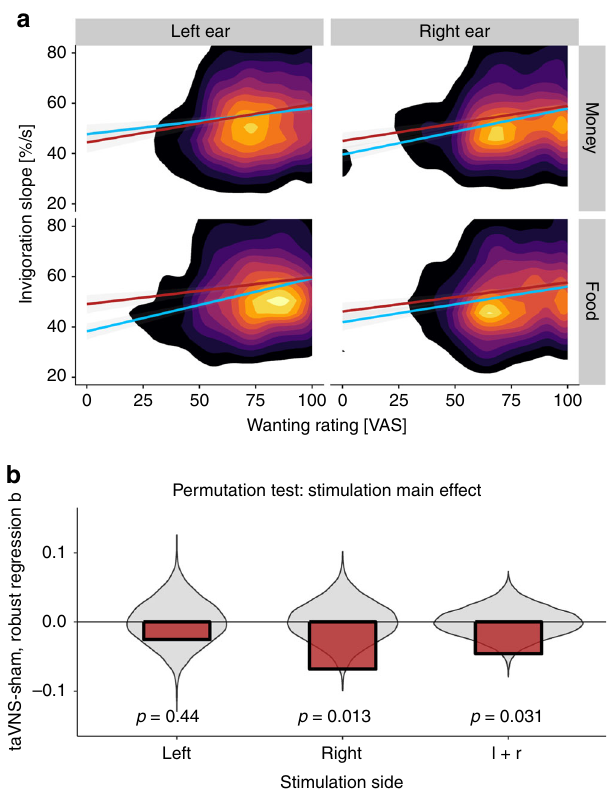
Fig. 5 Vagus nerve stimulation boosts the drive to work for less wanted rewards. a Overall, participants are slower to invigorate behavior if they want the reward at stake less as depicted in the 2d-density polygon (brighter colors indicate higher density of data). In line with univariate analyses, robust regression lines show that the slope re fl ecting the association between invigoration and wanting is decreased by transcutaneous auricular vagus nerve stimulation (taVNS: red line; sham is depicted as blue line). Again, no change was observed for monetary rewards after taVNS on the left side. b Compared to permuted data, taVNS induces signi fi cant changes in the association between invigoration and wanting. By fi tting robust regression coef fi cients, b , after permuting the labels for taVNS vs. sham stimulation, we compared the observed difference in slopes for taVNS — sham (in red) to a null distribution (violin plot in gray). This two-sided permutation test showed a signi fi cant main effect across both stimulation sides (l + r = left + right) and for taVNS on the right, but not the left side. On the left side, we observed an interaction with reward type instead, p = 0.029. VAS = visual analog scale. p -values are unadjusted for multiple comparisons. Source data are provided as a Source Data fi